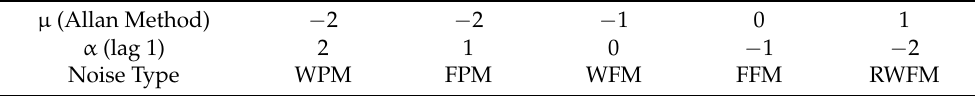
Table 1 lists the relationship of power, lower index α , and noise type. Table 1. Clock noise types, their Allan deviation slopes, and power spectral density coefficient indices. µ (Allan Method) − 2 − 2 − 1 0 α (lag 1) Noise Type WPM FPM WFM FFM